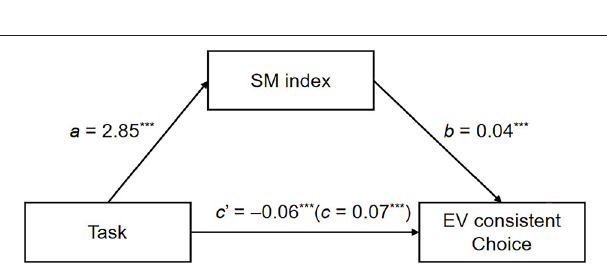
FIGURE 4 | Results of the mediation analysis of the SM index in Experiment 2. The indirect effect is the product of coefficients a and b . The coefficients in parentheses are the total effect (i.e., sum of indirect and direct effects). *** p <